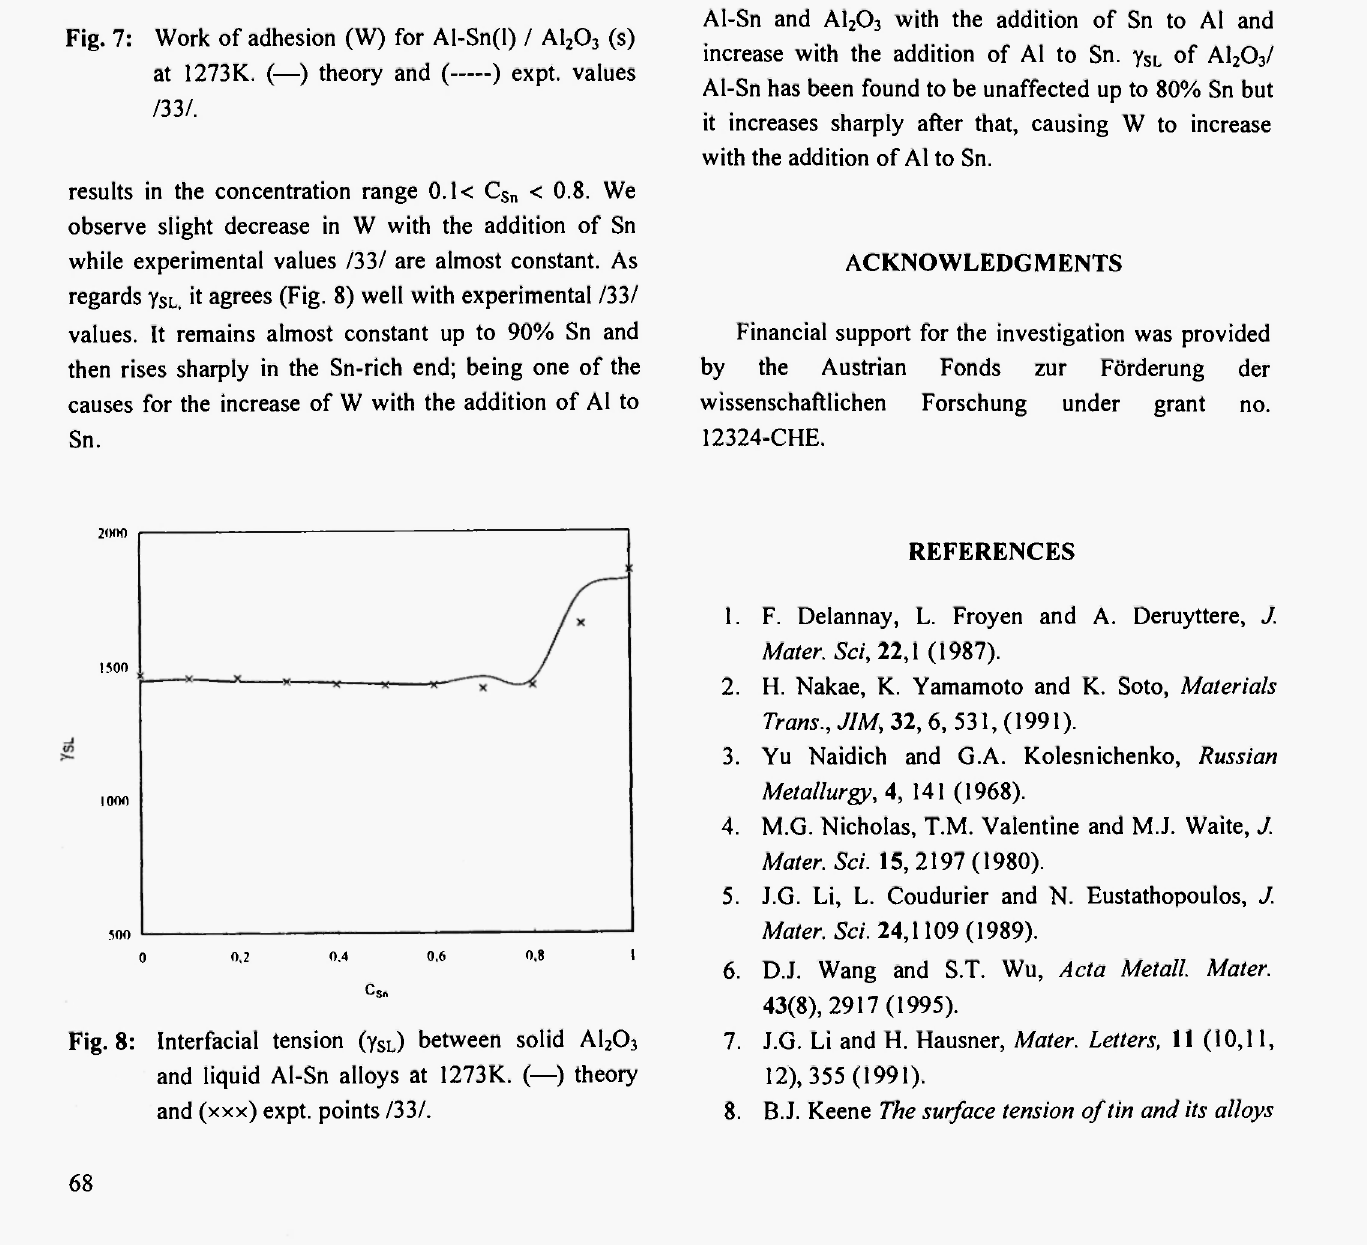
Fig. 7: Work of adhesion (W) for Al-Sn(l) / A1 2 0 3 (s) at 1273K. (—) theory and ( ) expt. values /33/.